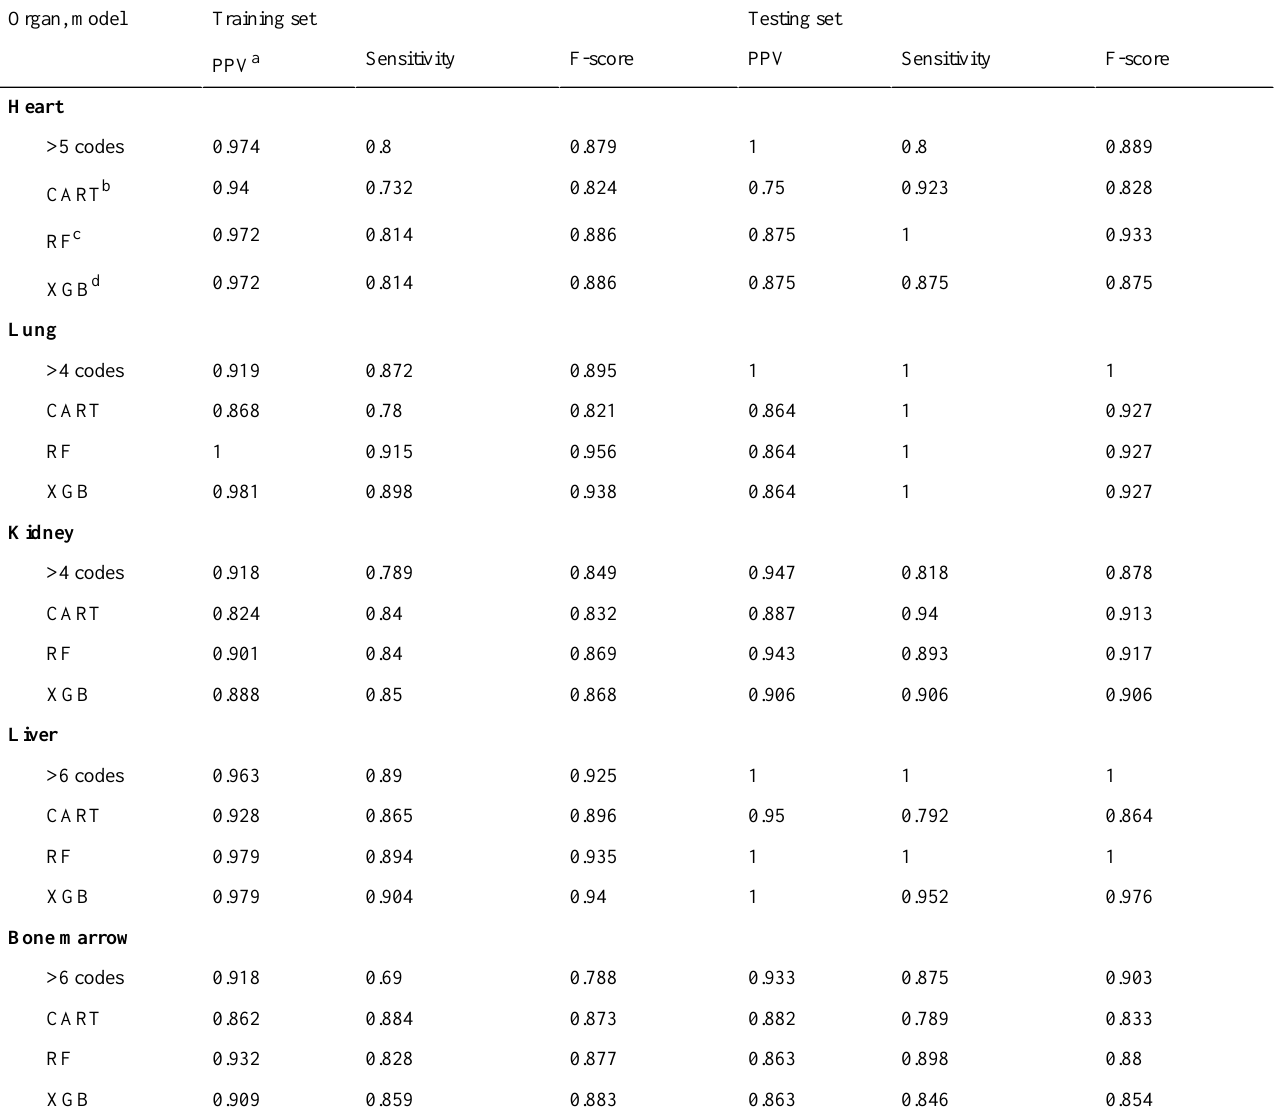
Table 4. Positive predictive value, sensitivity, and F-score for each machine learning model to identify individuals with specific organ transplant types in the training and testing sets.